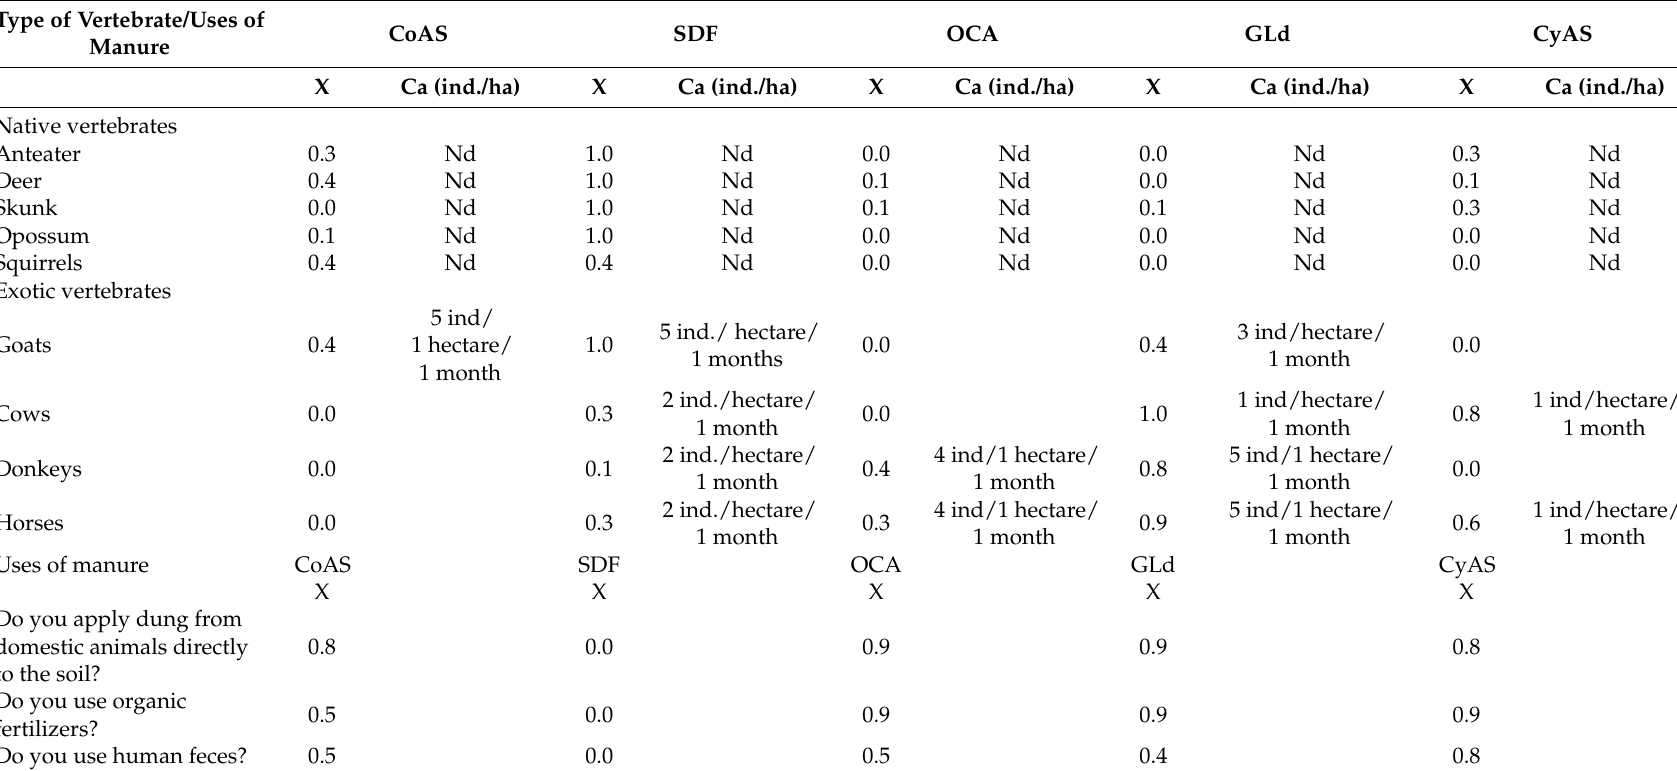
Table 5. Main vertebrates (native and domestic) inhabiting the different L-UCH classes and use of manure types. Mean values (X) close to 1 indicate frequent occurrence of these types of animal, while values around 0 indicate absence or less frequent occurrence of these types of animal. Type of Vertebrate/Uses